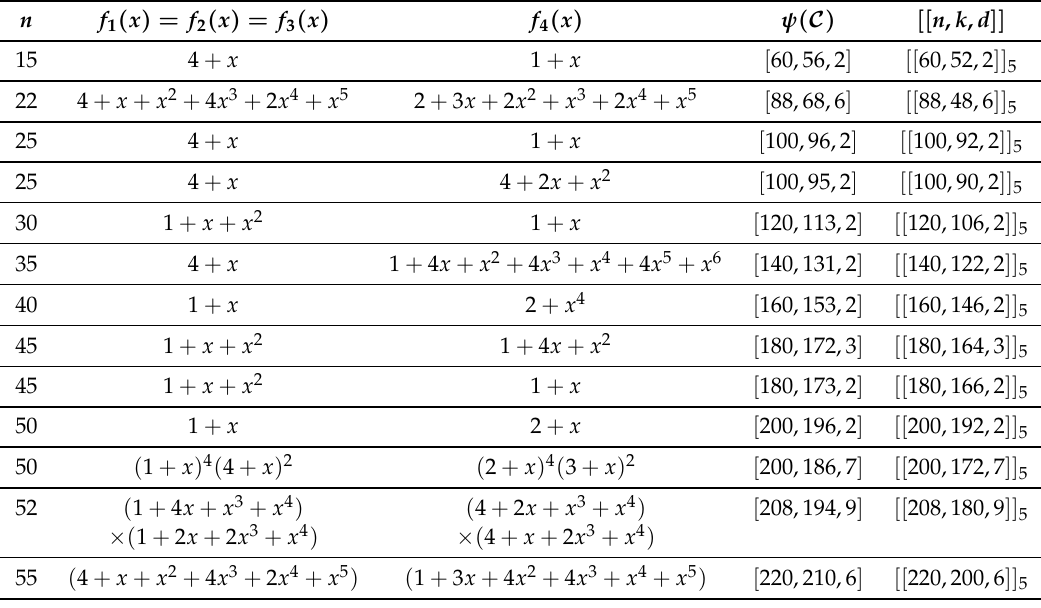
Table 2. Parameters of Quantum